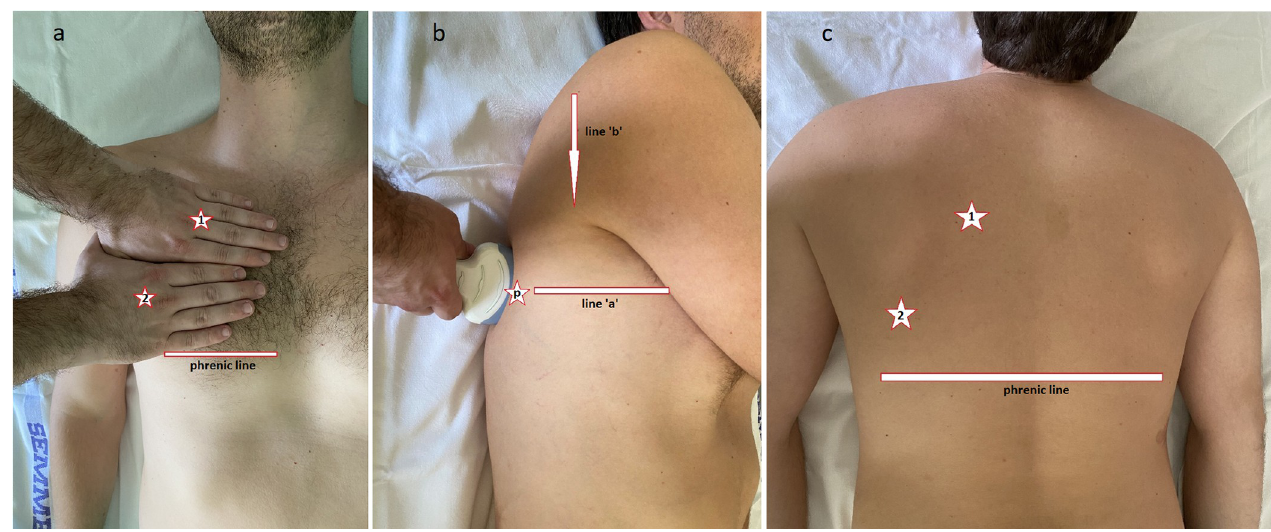
Fig 1. a-c. Imaging protocol: BLUE-points. a : 1 = ‘upper’ and 2 = ‘lower’ BLUE-points on supine patients , b : p = ‘PLAPS’-point (postero-lateral alveolar and/or pleural syndrome) , line ‘a’ = horizontal line to the ‘lower’ BLUE-point , line ‘b’ = posterior axillary line on supine patients , c : 1 = ‘upper’ and 2 = ‘lower’ BLUE- points on prone patients